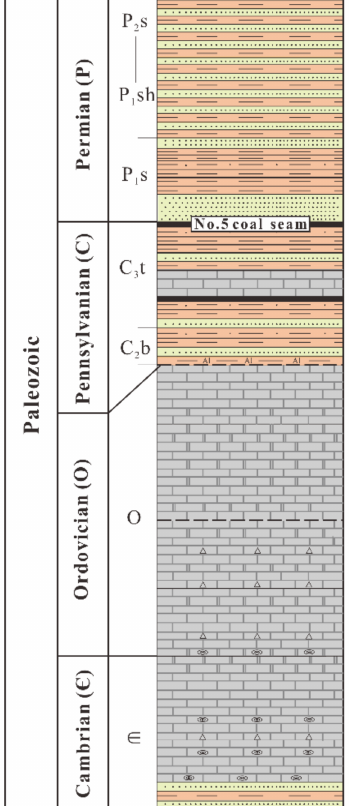
Figure 2. Stratigraphic column in the Weibei Field (Yan et al., 2015